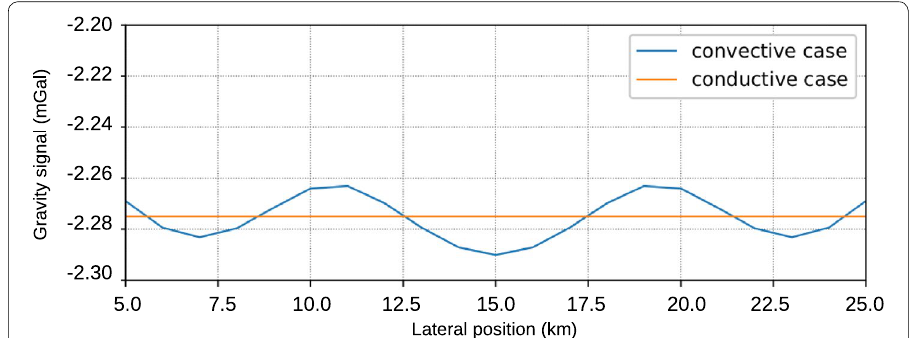
Fig. 8 Comparison between the calculated gravimetric profile of the 2D model between the fully thermal diffusive case (orange line) and the case associated to the large-scale convective system (blue